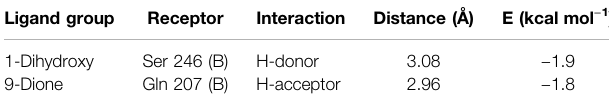
TABLE 3 | Bmal1 and Physcion hydrogen